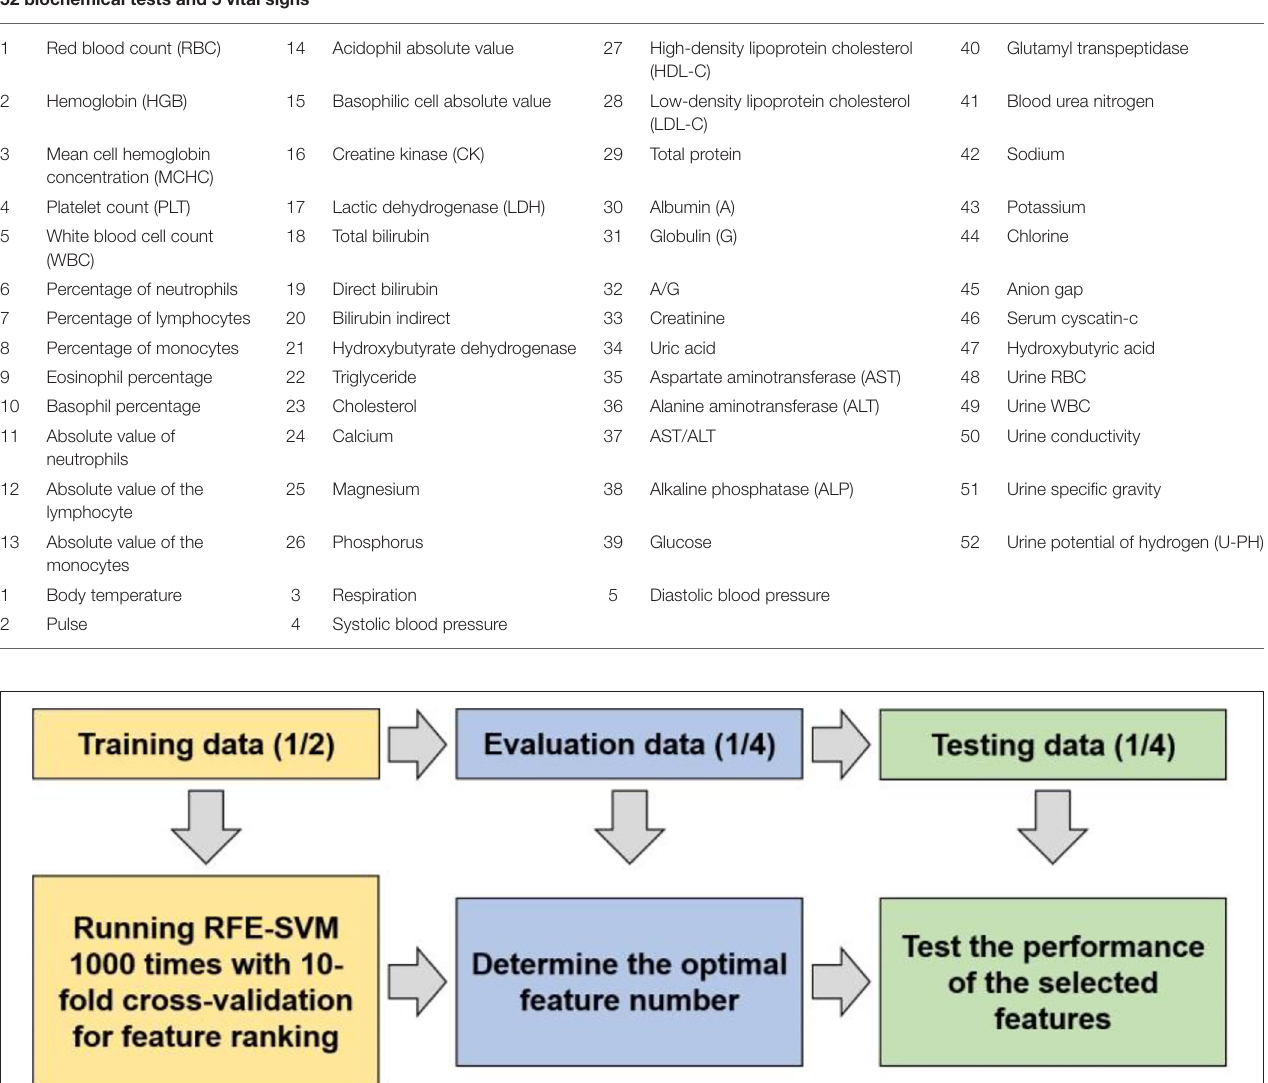
Table 1 showed analyzed 52 biochemical tests and 5 vital signs for both groups, including red blood count (RBC), acidophil